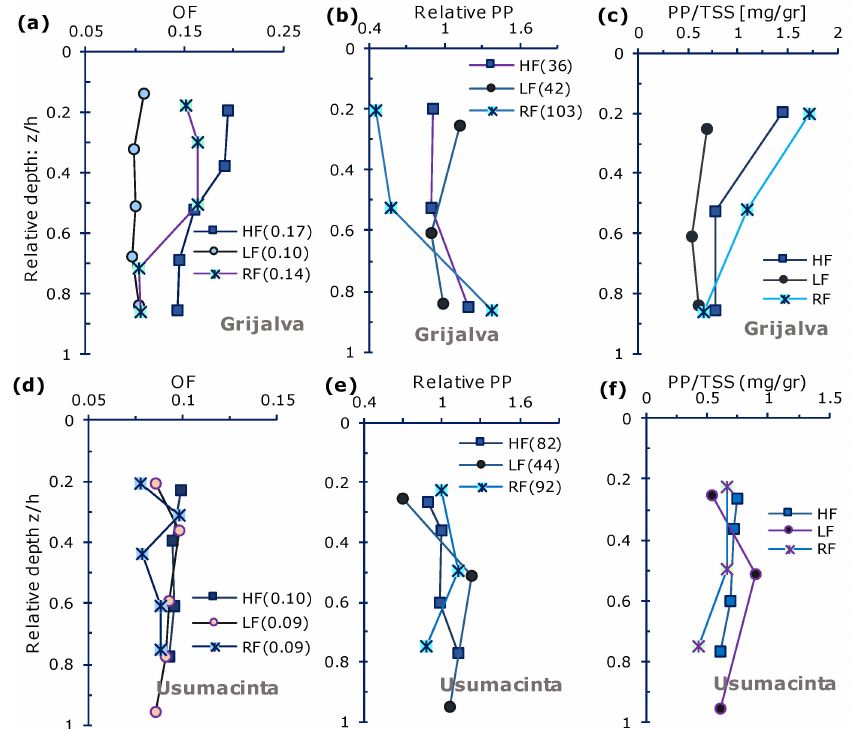
Figure 6. Seasonal variation in profiles of Organic fraction (OF) and particulate phosphorous (PP). In panels ( a , d ), mean OF is showed in parenthesis. In panels ( b , e ), relative PP = local PP/mean PP (mean PP showed at parenthesis in µ g/L). Panels ( c , f ): amount of P in the suspended solids (PP/TSS). HF: High flow (November 2021); LF: Low flow (April 2022); RF: Raising flow (August 2022). Particulate phosphorus represented between 0.50 to 0.95 of TP and varied